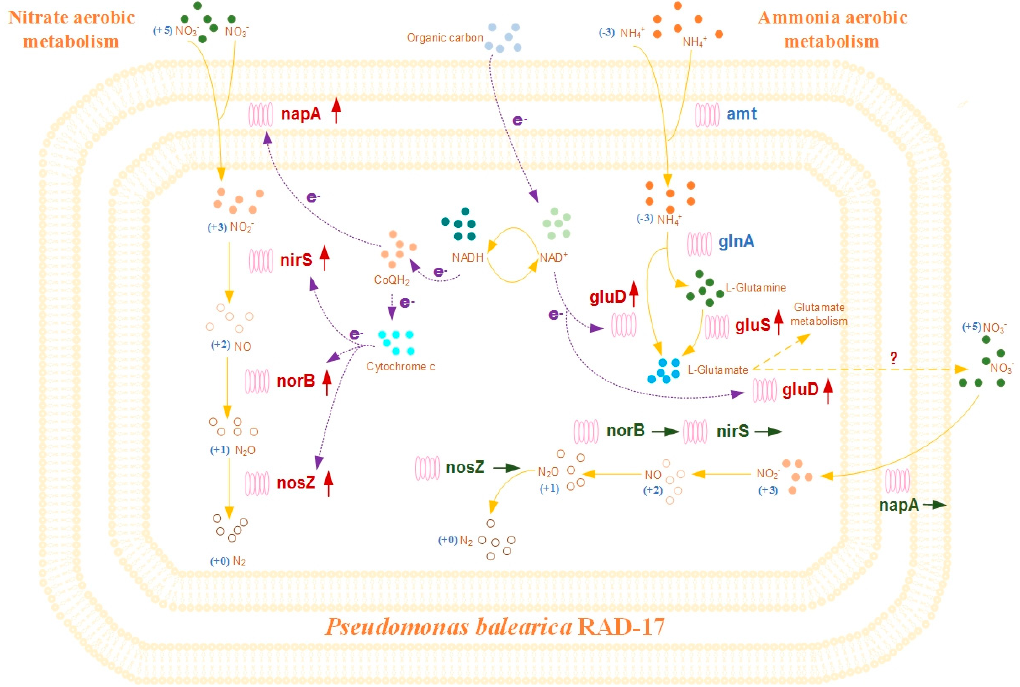
Figure 6. Proposed model for aerobic nitrogen removal mechanisms of the Pseudomonas balearica strain RAD-17. Red arrow means gene up-regulation; green arrow means inconspicuous gene regulation.